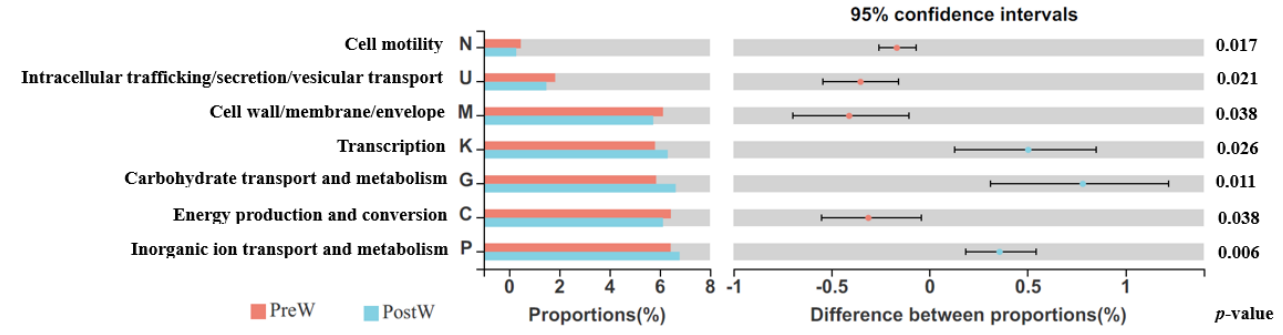
Figure 11. Comparison of COG functional abundance in oral microbiota between preweaning and postweaning donkeys. Proportion of COG abundance differences within the 95% confidence interval. COG, clusters of orthologous groups of proteins; PreW, preweaning group; PostW, postweaning group.